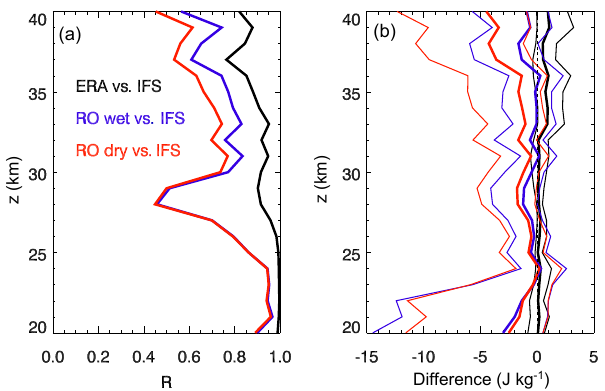
Figure 10. (a) Correlation coefficients as a function of altitude for the correlation between ERA-Interim and IFS data (black line), RO- wet and IFS data (blue line), and RO-dry and IFS data (red line). (b) Corresponding median temperature differences (thick lines) along with 10 and 90% percentiles (thin lines) as a function of alti- tude (same color code as in panel a